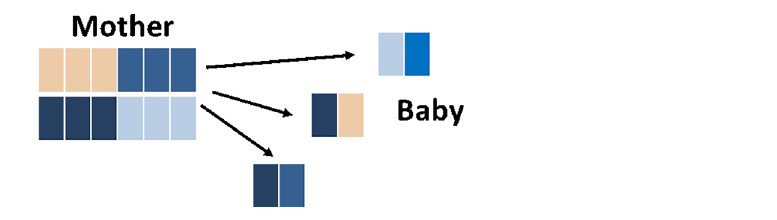
FIGURE 3 Illustration of the mother and baby approach.